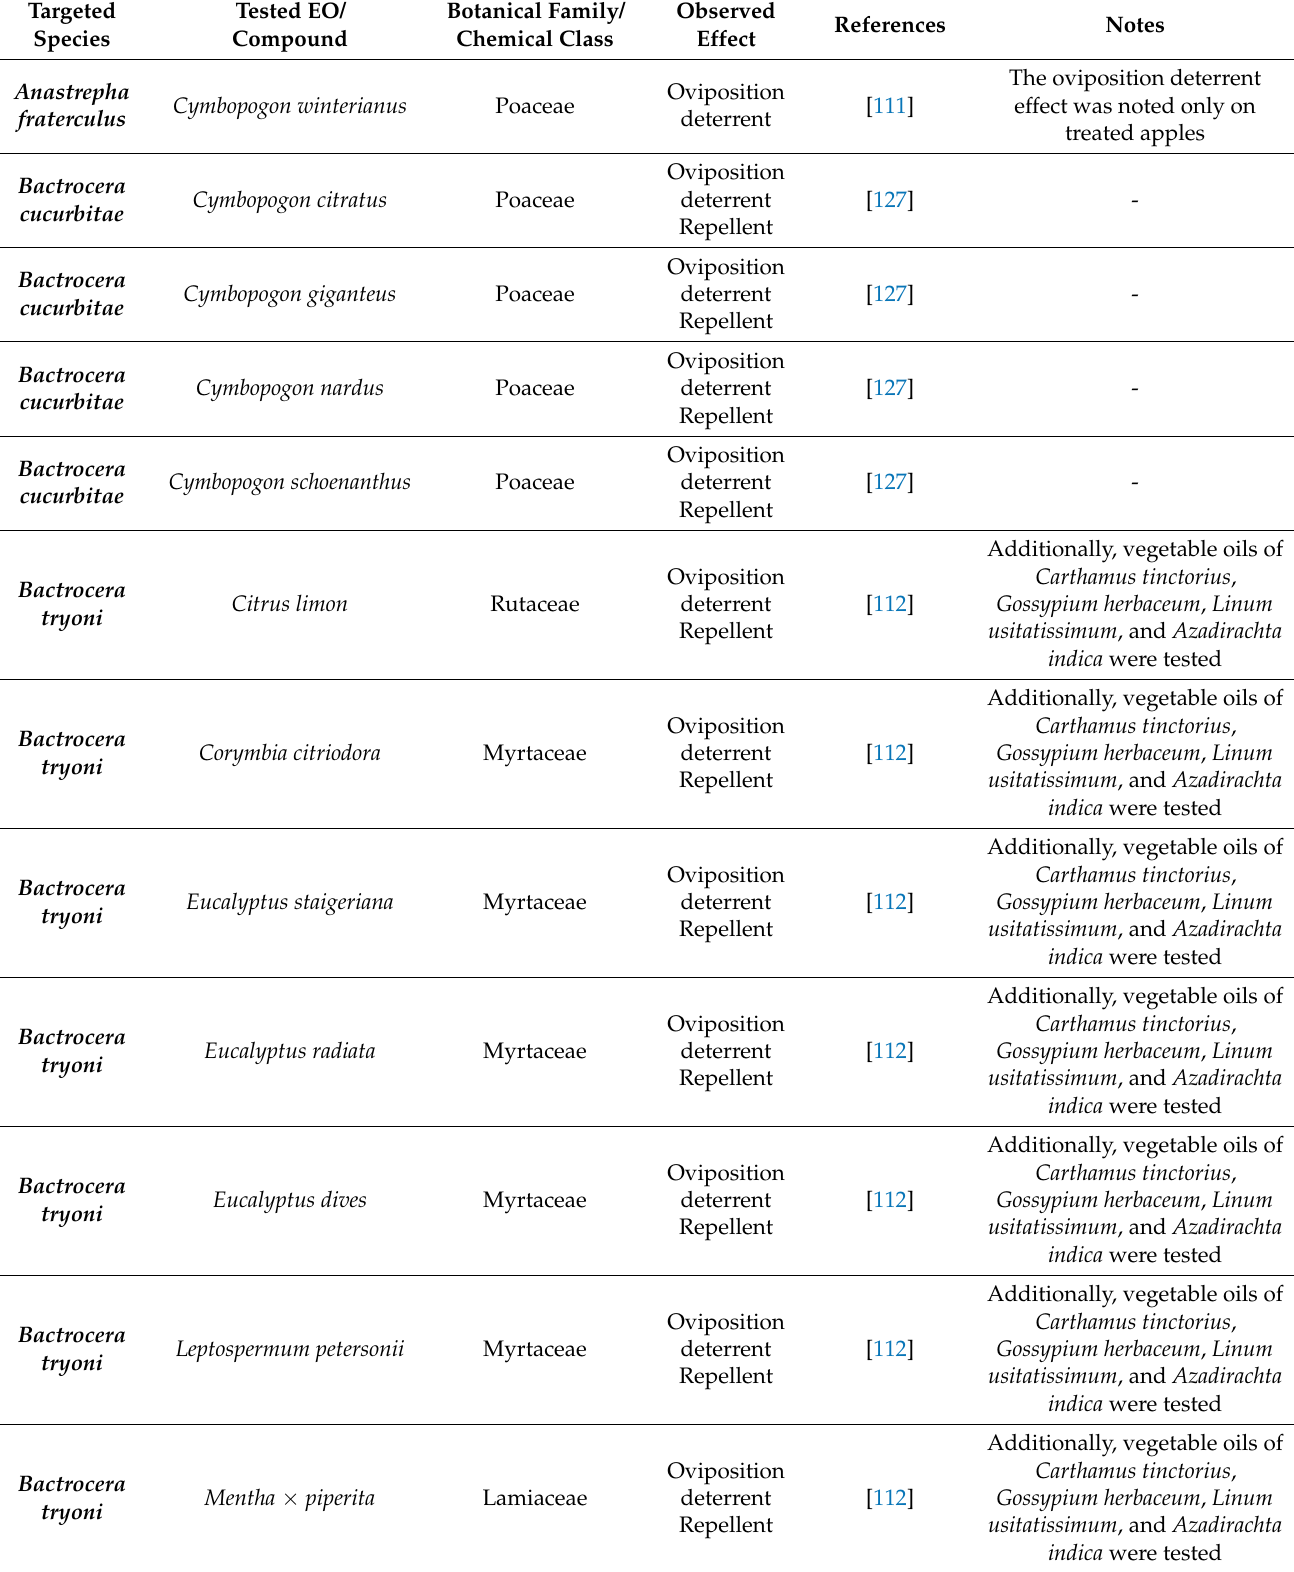
Table 1. Essential oils (EOs) were examined for repellent activity on Tephritidae flies. In addition to tested essential oil, the mode of action and the observed repellent effect are